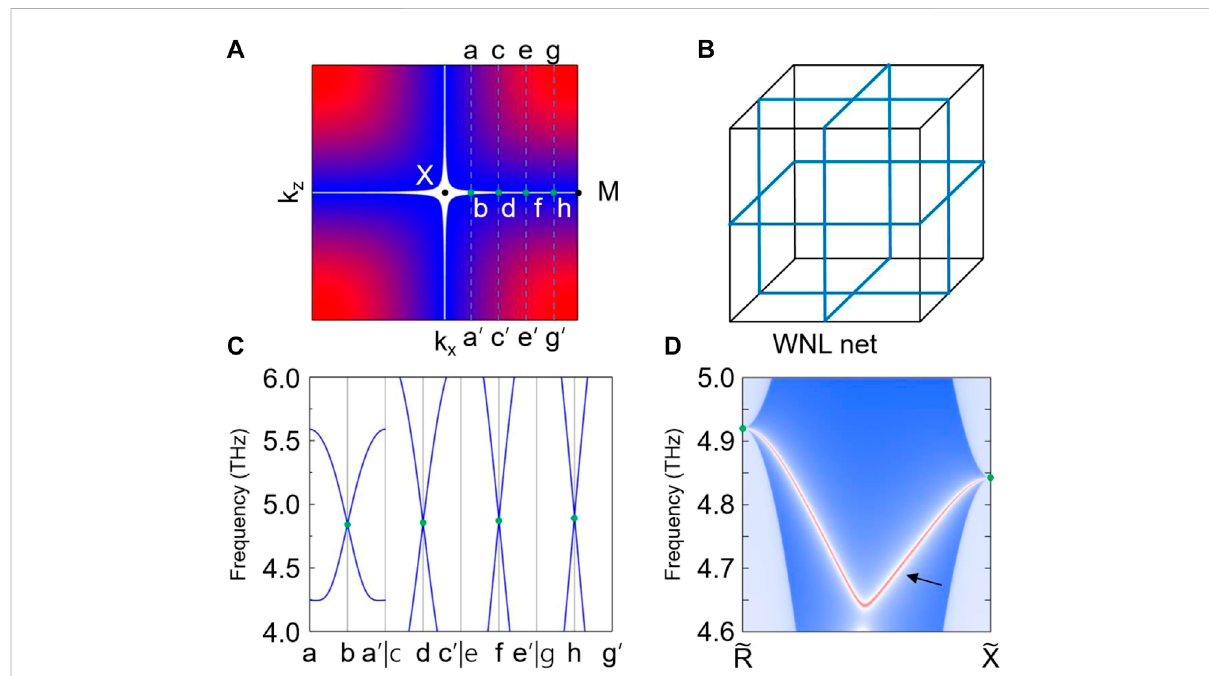
FIGURE 3 (A) Amapofenergygapsbetween thetwocrossingbranchesaround5 THzintheky= π plane. (B) AschematicdiagramofWeylnodalnetin3D BZ. (C) Phonon dispersions of Ag 2 O along the a-b-a ’ , c-d-c ’ , e-f-e ’ , and g-h-g ’ paths. (D) Phononic drumhead-like surface states in (010)